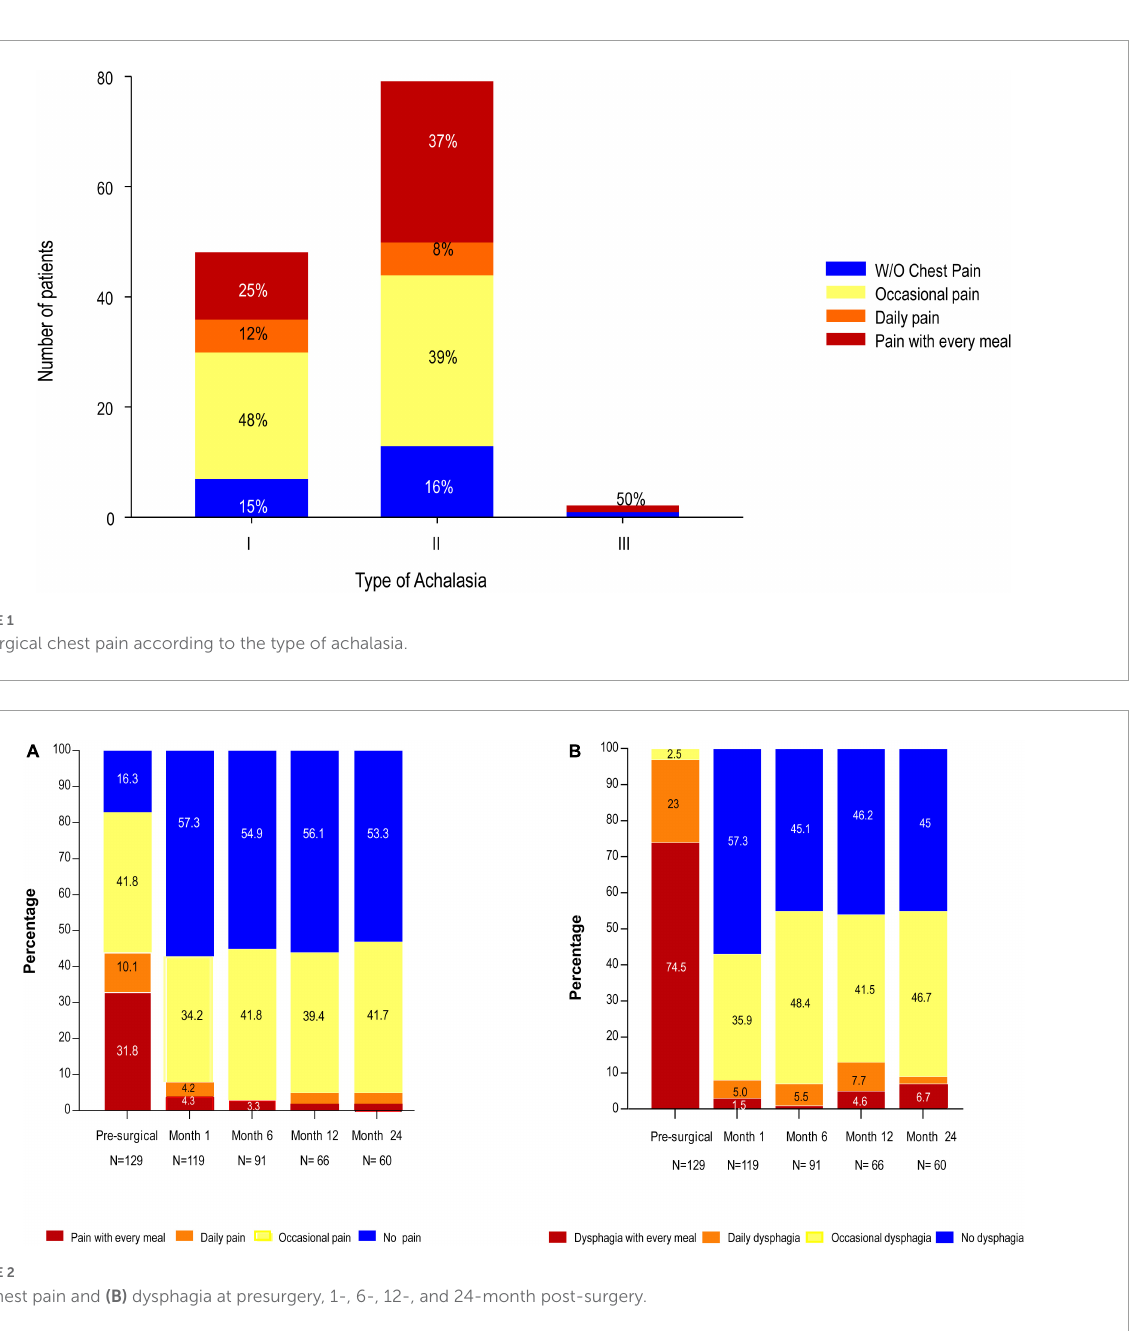
A 1 month after surgery, the number of patients without chest pain increased 3-fold ( n = 69) compared to presurgery patients ( n = 21; Figures 2A,B ). Dysphagia decreased in patients without and with chest pain (25 and 64 vs. 100%; P < 0.00001; Figure 3 and Supplementary Table 1 ) compared to presurgery. Patients without chest pain had lower Eckardt score (1.2 ± 1.3 vs. 3.0 ± 2.3; P < 0.001; Supplementary Table 1 ), GERD-HRQL patients with chest